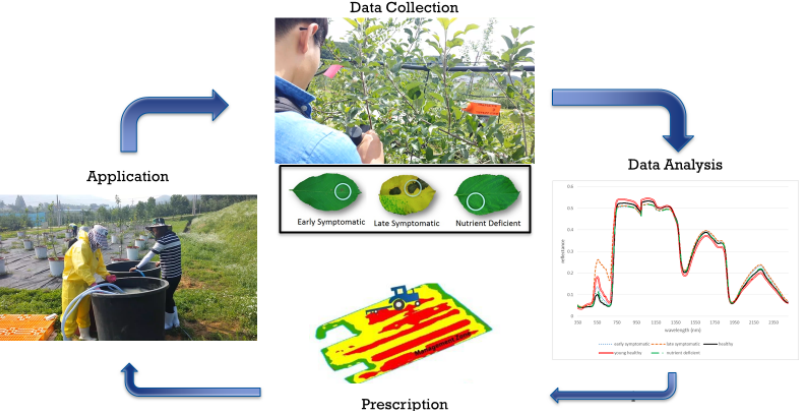
Figure 1. Flow chart of the precision agricultural process, including researchers implementing the PA process in an apple orchard in Gunwi, Republic of Korea, July 16, 2015. Courtesy of Brianna